Question: Sum up the contents of this chart in one sentence.
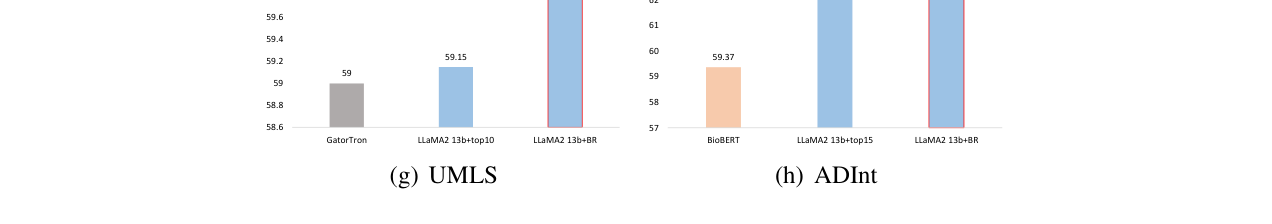
Answer: F1(a-h)/Accuracy(i) performance of different models. BR refers to BIOMEDRAG. The red font indicates the performance of BIOMEDRAG.